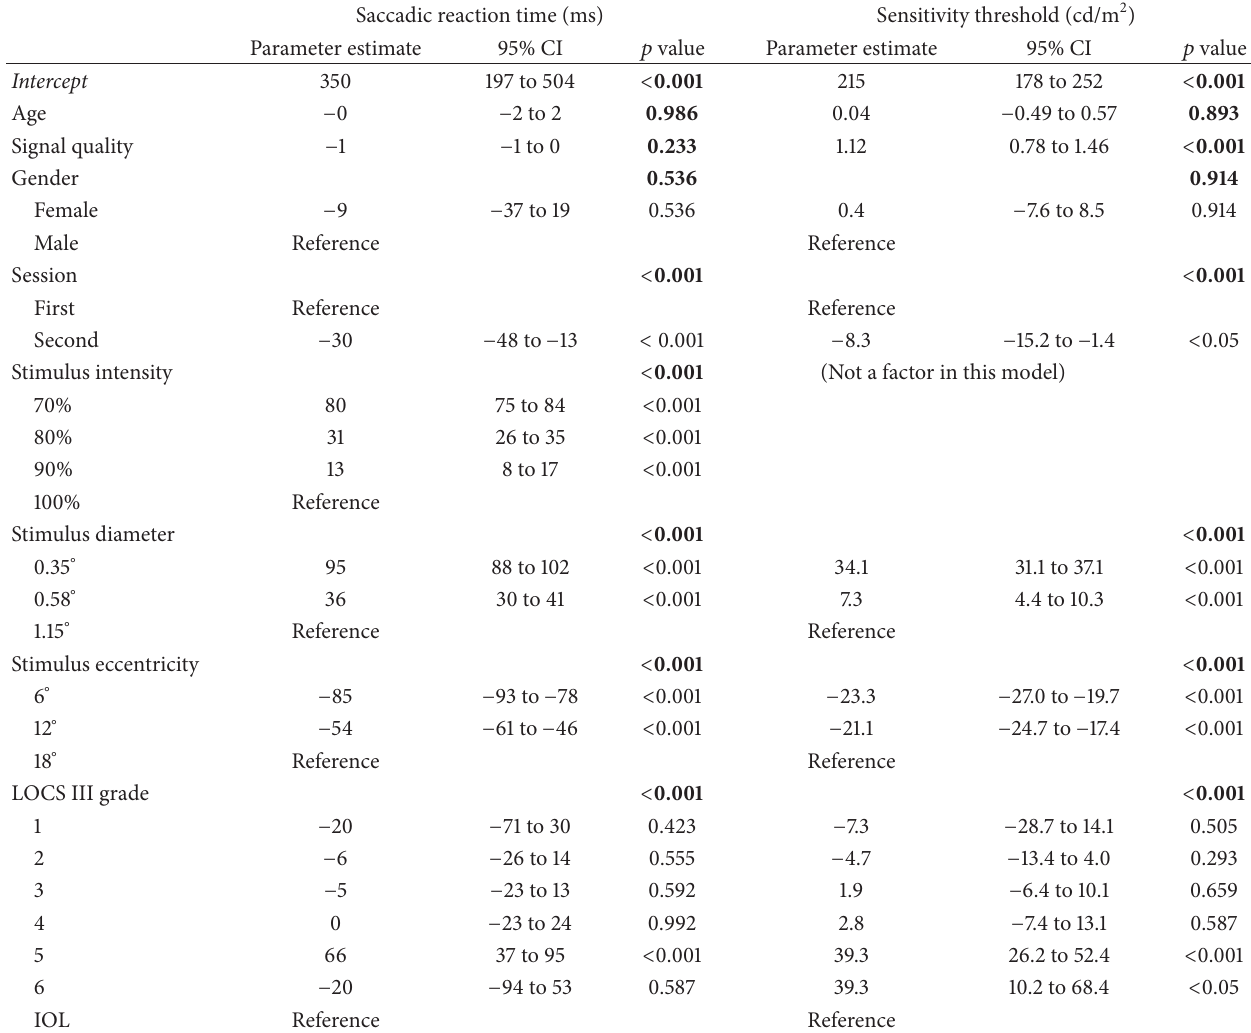
LOCS III: Lens Opacity Classification System III and CI: confidence